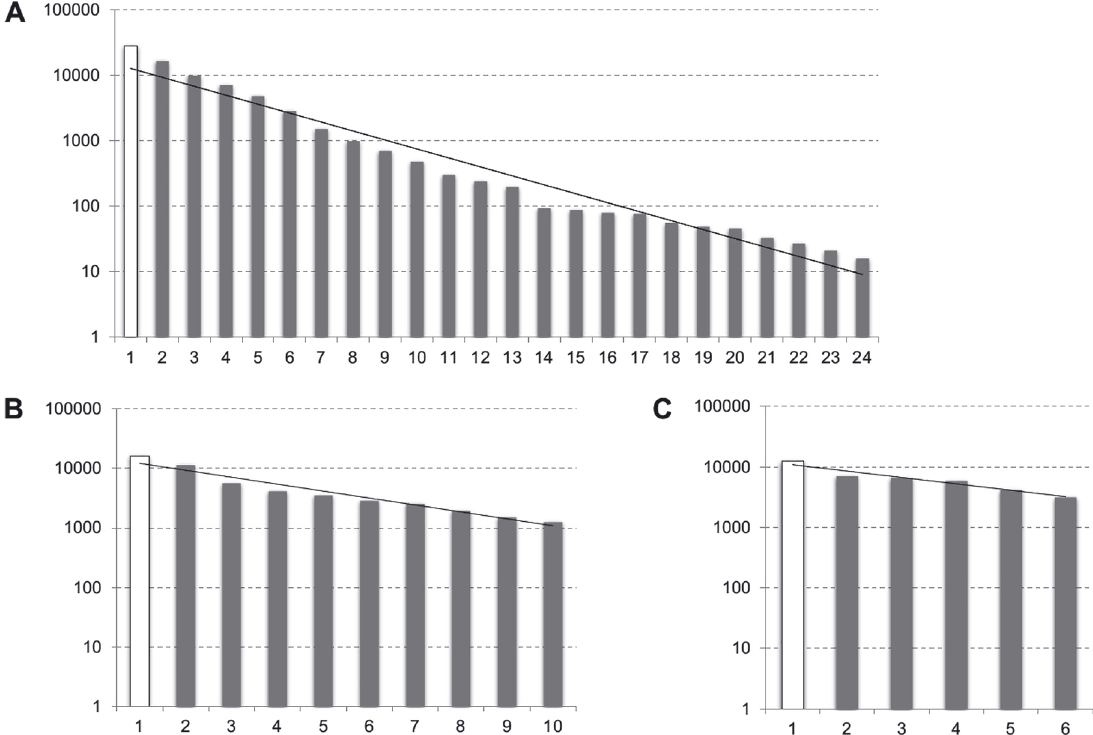
Figure 5: Dependence of the number of clusters of binding sites on cluster size. A – Arabidopsis thaliana , B – Physcomitrella patens , C – Chlamydomonas reinhardtii . Axis X shows the number of sites in the cluster, axis Y – the number of such clusters. Single binding sites (size 1, singletons) are shown by the hollow column. The values are displayed on semi-logarithmic